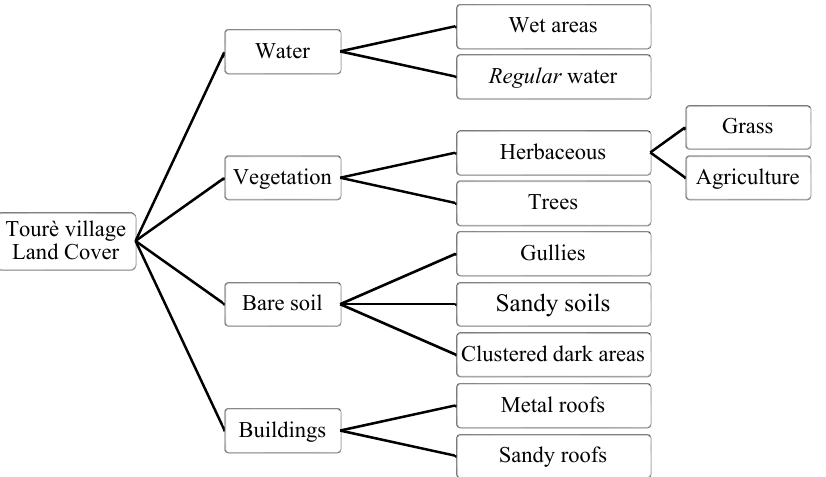
Figure 5. Classification legend structure. It is composed of 4 macro-classes (buildings, bare soil, vegetation, and water); nine classes and two sub-classes (grass and agricultural land).